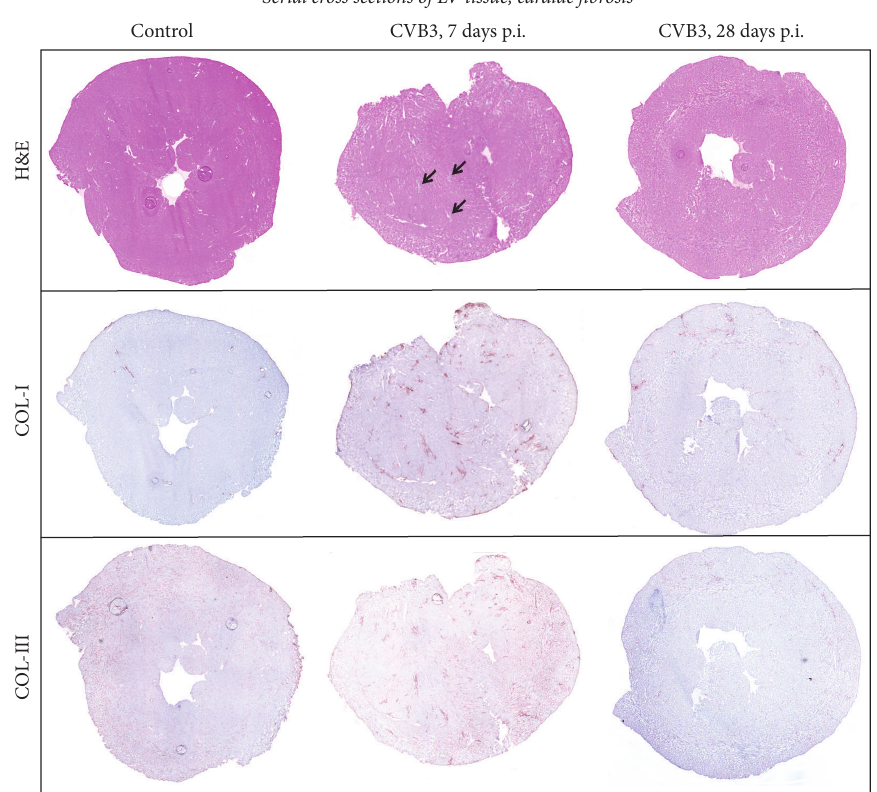
Figure 5: Remodeling: serial cross section of LVs from C57BL/6J mice without viral infection or 7 as well as 28 days after intraperitoneal CVB3 infection. Cardiac tissue of healthy or CVB3-infected C57BL/6J mice were stained for COL-I and COL-III. Hematoxylin/eosin staining revealed infiltrated cells. The foci of inflammation are clearly shown 7 days after infection indicated by arrows. Histological staining of COL-I showed a clear increase in fibrosisafter CVB3infection within thefoci of inflammation. Immunohistochemistryof COL-IIIreveals no distinct effect of CVB3